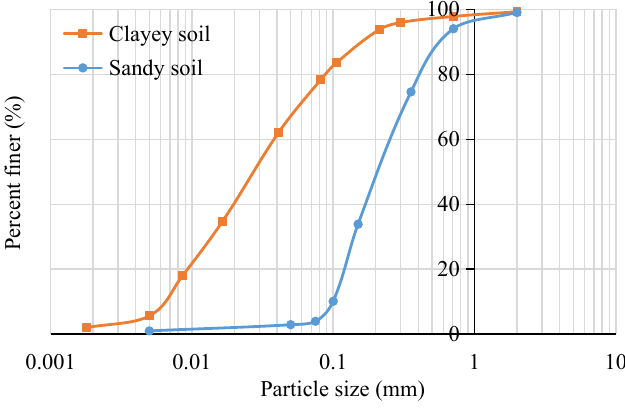
Figure 1. Particle size distribution. Table 1. The basic property indices of soil.